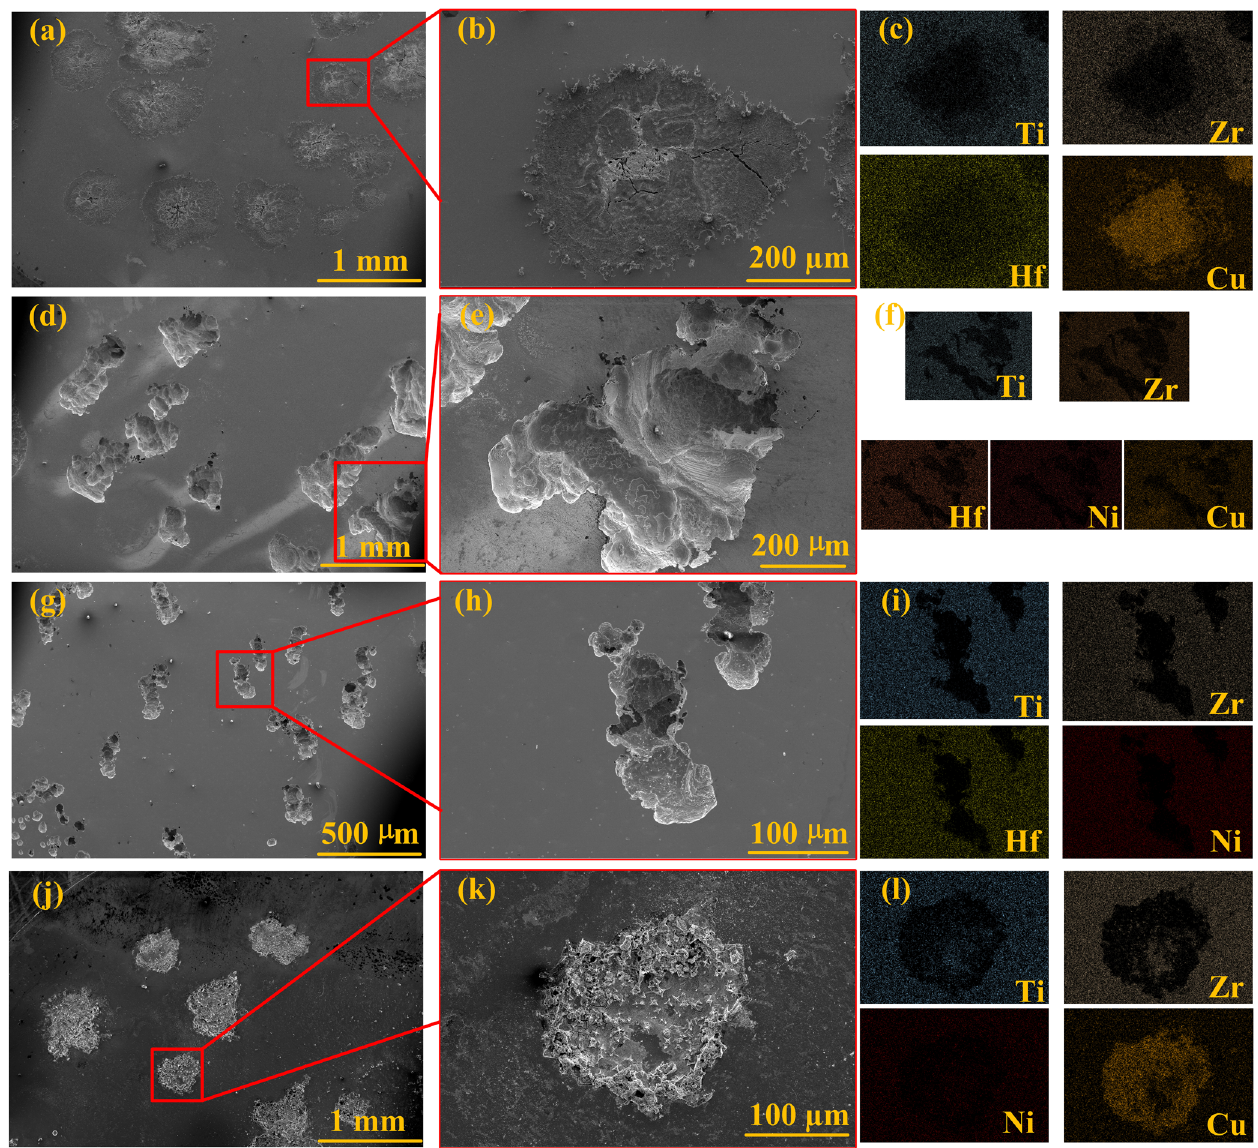
Fig. 4 The backscattered electron (BSE) image of the pit morphologies of the four samples. The SEM observations were performed immediately after the potentiodynamic polarization measurements in 3.5 wt. % NaCl solution. a TC sample, b magni fi ed image of the area marked by the red square in a , and c EDS element mapping of the test area corresponding to b . d TCN sample, e magni fi ed image of the area marked by the red square in d , and f EDS element mapping of the test area corresponding to e . g TN sample, ( h ) magni fi ed image of the area marked by the red square in g , and i EDS element mapping of the test area corresponding to h . j Vit1 sample, k magni fi ed image of the area marked by the red square in j , and l EDS element mapping of the test area corresponding to k